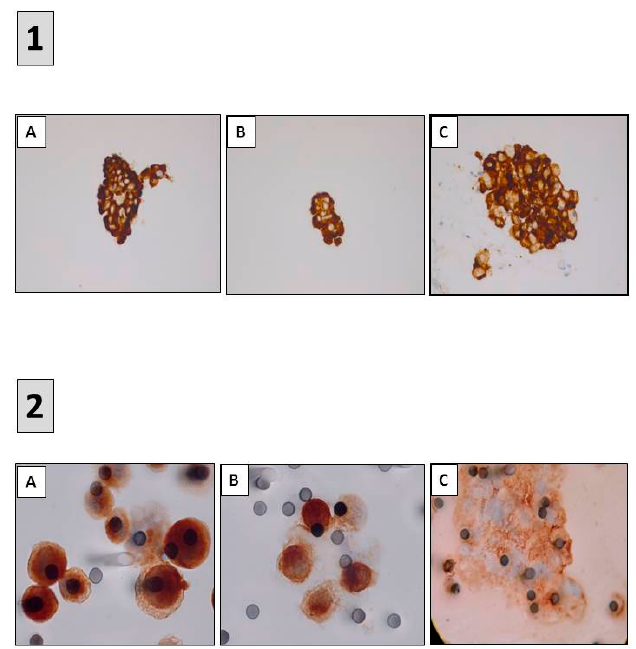
Figure 5. Detection of predictive biomarkers using immunocytochemistry (ICC). ( 1 ) ALK ICC (D5F3) ( A ) ROS1 ICC (D4D6) ( B ) and PD-L1 ICC (22C3) ( C ) performed on samples obtained after endobronchial ultrasound trans-bronchial needle aspirations ( A – C ) immunoperoxidase, magnification × 400. ( 2 ) ALK ICC (D5F3) ( A ) MET ICC (SP44) ( B ) and PD-L1 ICC (22C3) ( C ) performed on circulating tumor